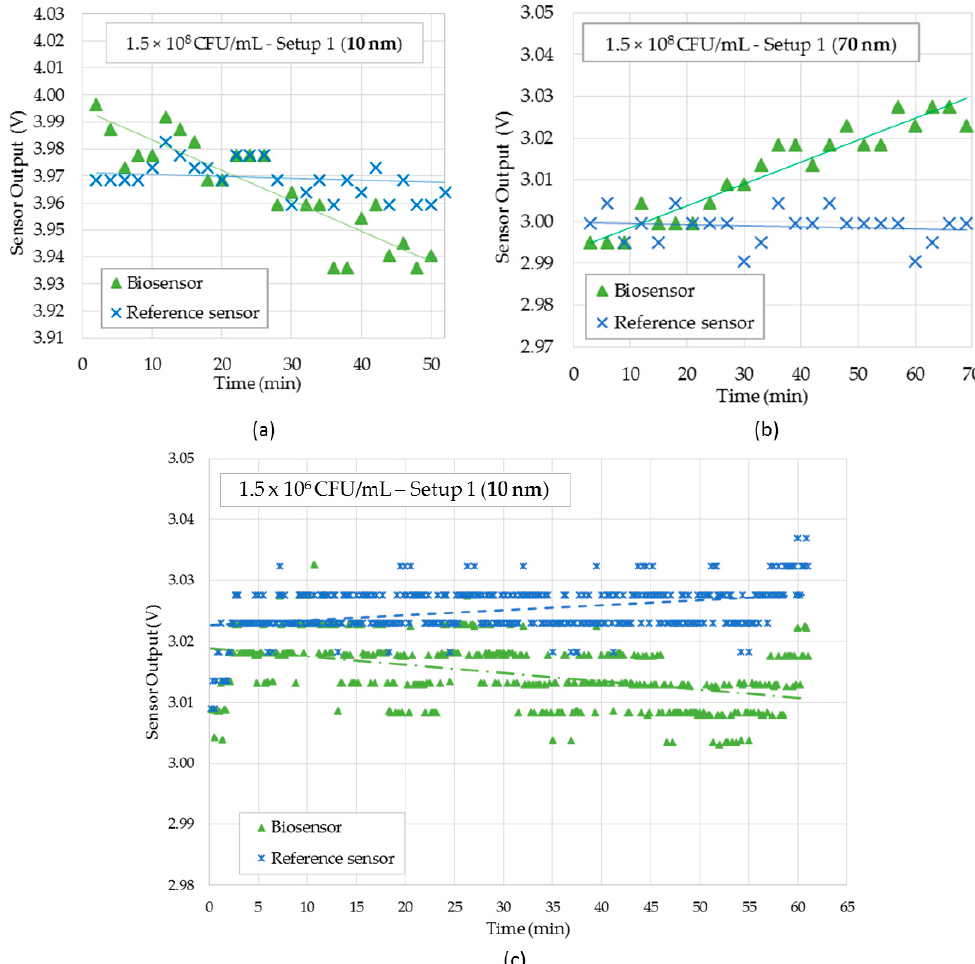
Figure 9. Sensor responses for bacterial suspensions using Setup 1. ( a ) Sensor probe and reference probe for 10 nm gold-coated at 1.5 × 10 8 CFU/mL bacterial suspension; ( b ) Sensor probe and reference probe for 70 nm gold-coated probes in 1.5 × 10 8 CFU/mL bacterial suspension; ( c ) Sensor probe and reference for 10 nm gold-coated probes in 1.5 × 10 6 CFU/mL bacterial suspension.